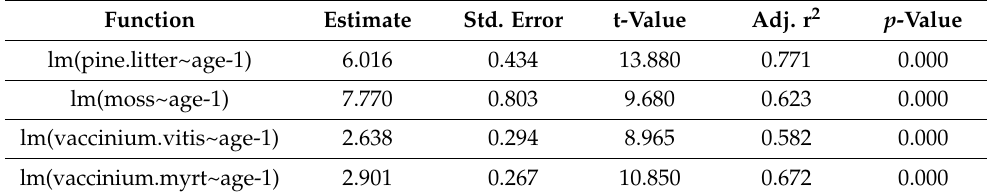
Table 7. Relationships between the proportion of different ground cover types and pine seedling age; all study sites